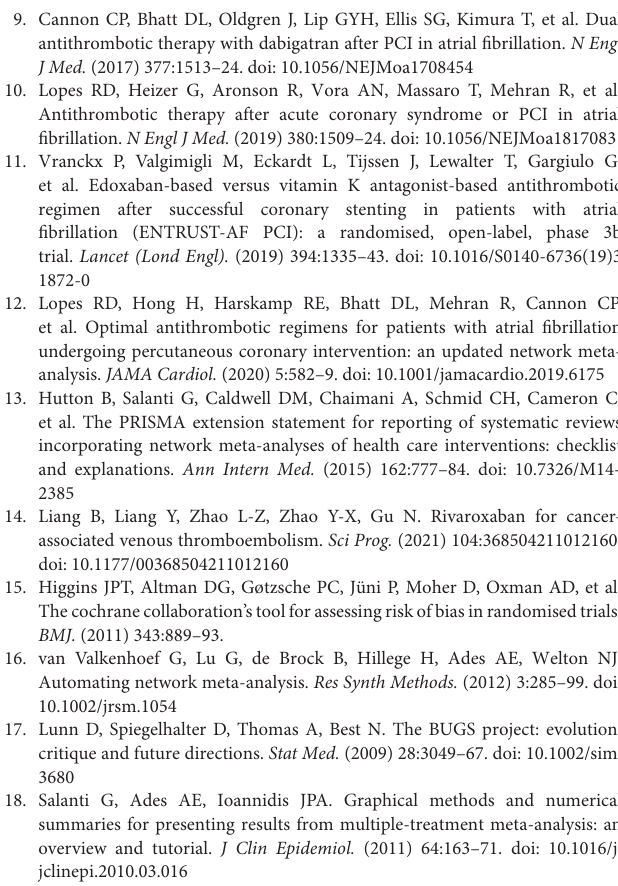
Supplementary Figure 1 | Model diagnostics under the assumption of evidence consistency. (A) TIMI major bleeding. (B) TIMI major and minor bleeding. (C) Trial-defined primary bleeding events. (D) Intracranial hemorrhage. (E) Trial-defined MACE. (F) All-cause mortality. (G) Cardiovascular mortality. (H) MI. (I) Stroke. (J) Stent thrombosis. (K) Hospitalization. Supplementary Figure 2 | Checking the assumption of evidence